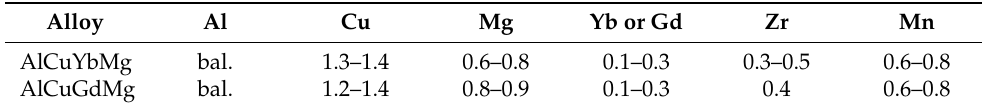
Table 2. As-cast composition of the Al solid